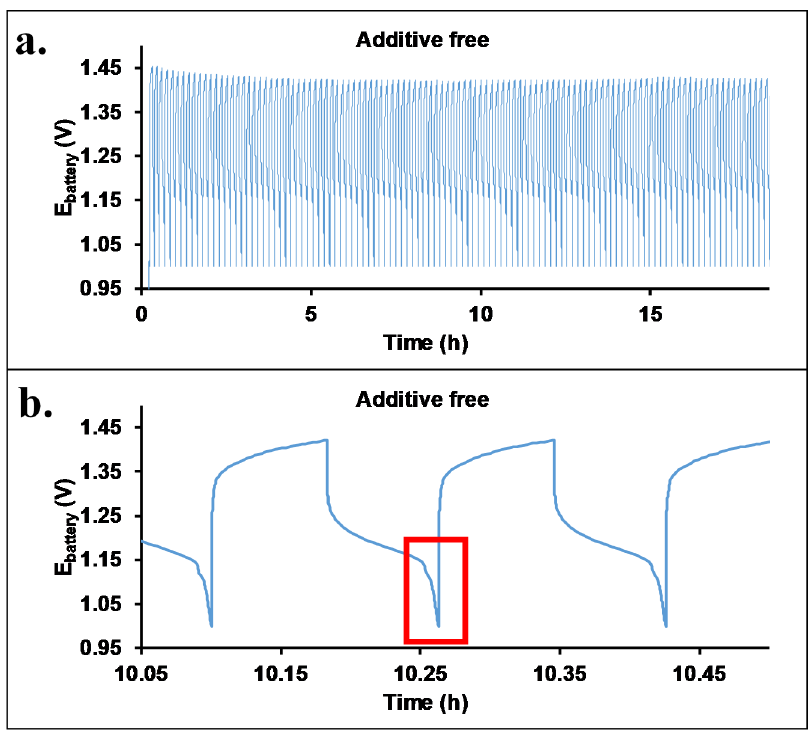
Figure 2. The cyclic performance test ( a ) of the Zn-air battery filled with additive-free electrolyte, aqueous KOH (6 M) and K 2 [(Zn(OH) 4 )] (0.25 M). The lower figure ( b ) shows the zoomed charg- ing/discharging cycles (the sharp decreasing in the cell potential is highlighted by red frame).